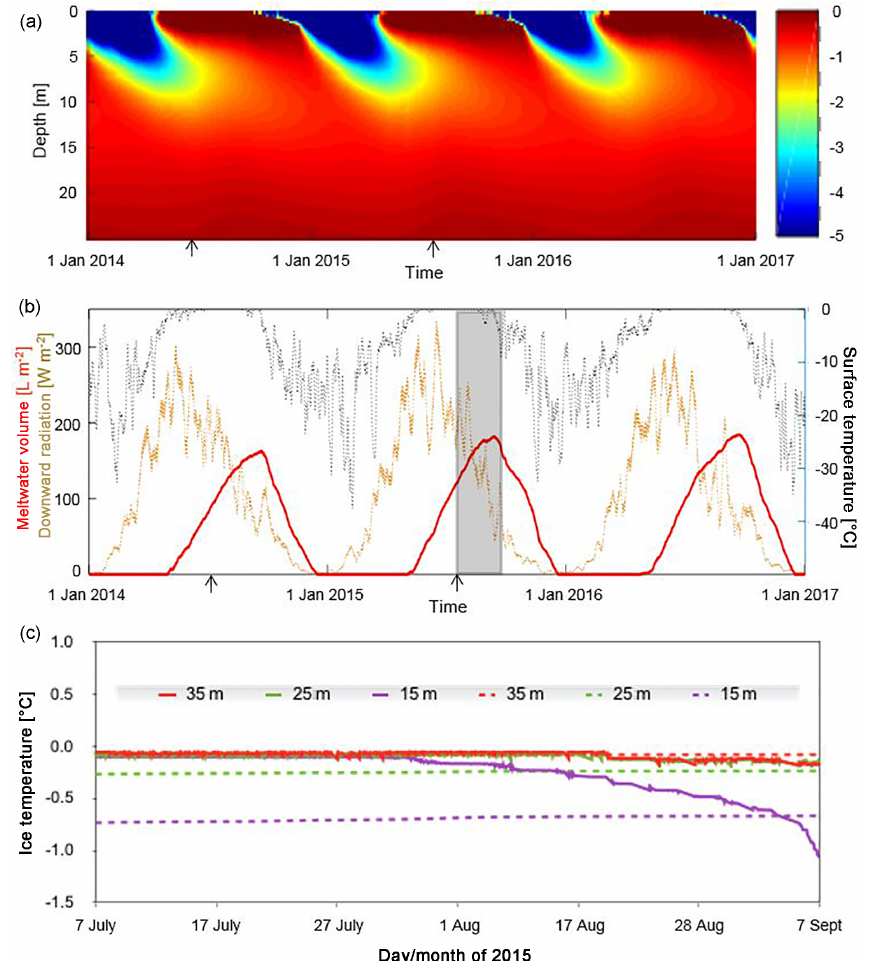
Figure 1. Temperature and ice water content from 2014 to 2016. (a) Modeled ice temperature was calculated using a finite-difference solver to a one-dimensional diffusion–advection–production equation. Only values between 0 (red limit) and − 5 ◦ C (blue limit) are plotted. (b) The model is driven by the ERA-Interim reanalysis 2m air temperature (black dots) and downward radiation data (brown dots) for the region (Dee et al., 2011). Both forcings are plotted at hourly intervals after smoothing with a daily (surface temperature) and weekly (radiation) running- average filter to suppress short-term variability. The grey region in panel (b) represents the summer 2015 interval plotted in panel (c) when ice temperature data were collected. The arrows in panels (a) and (b) indicate the timing of the two field campaigns. (c) Comparison among ice temperatures observed with thermistors placed in a borehole at 15, 25, and 35m below the surface from early July to early September of 2015 (solid lines) and the simulated ice temperatures (dashed lines) for the same depths below the surface of the model